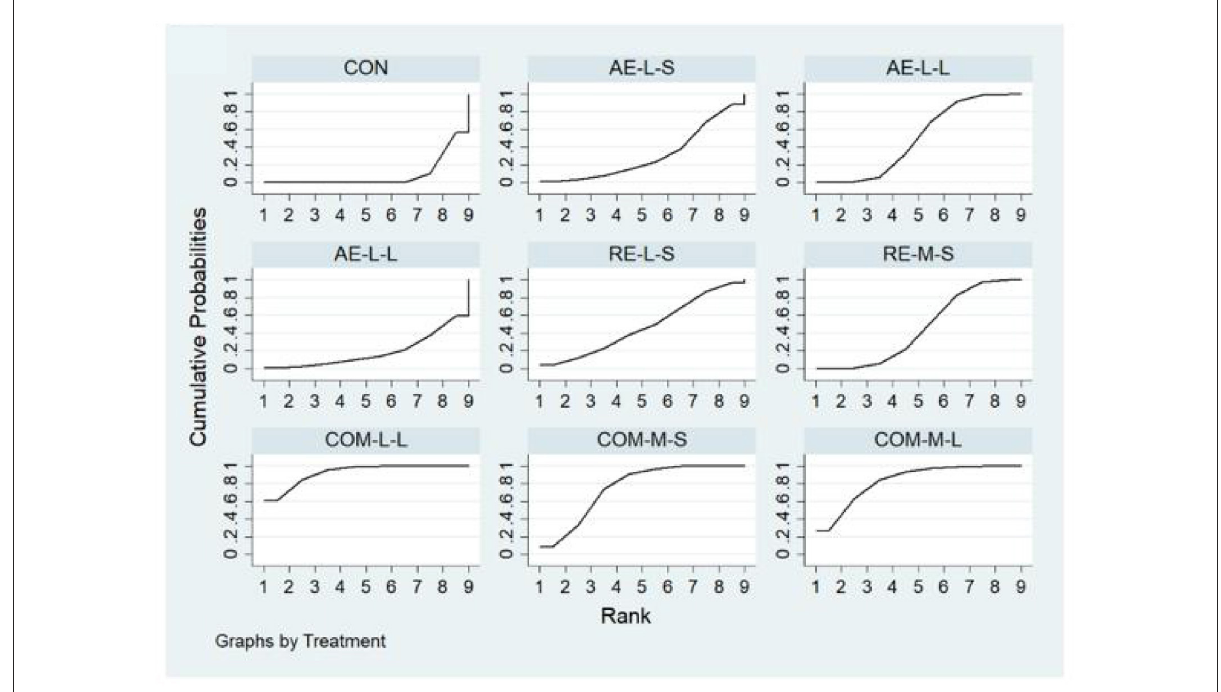
FIGURE4 The surface under the cumulative ranking curve (SUCRA) ranking chart for FIQ.